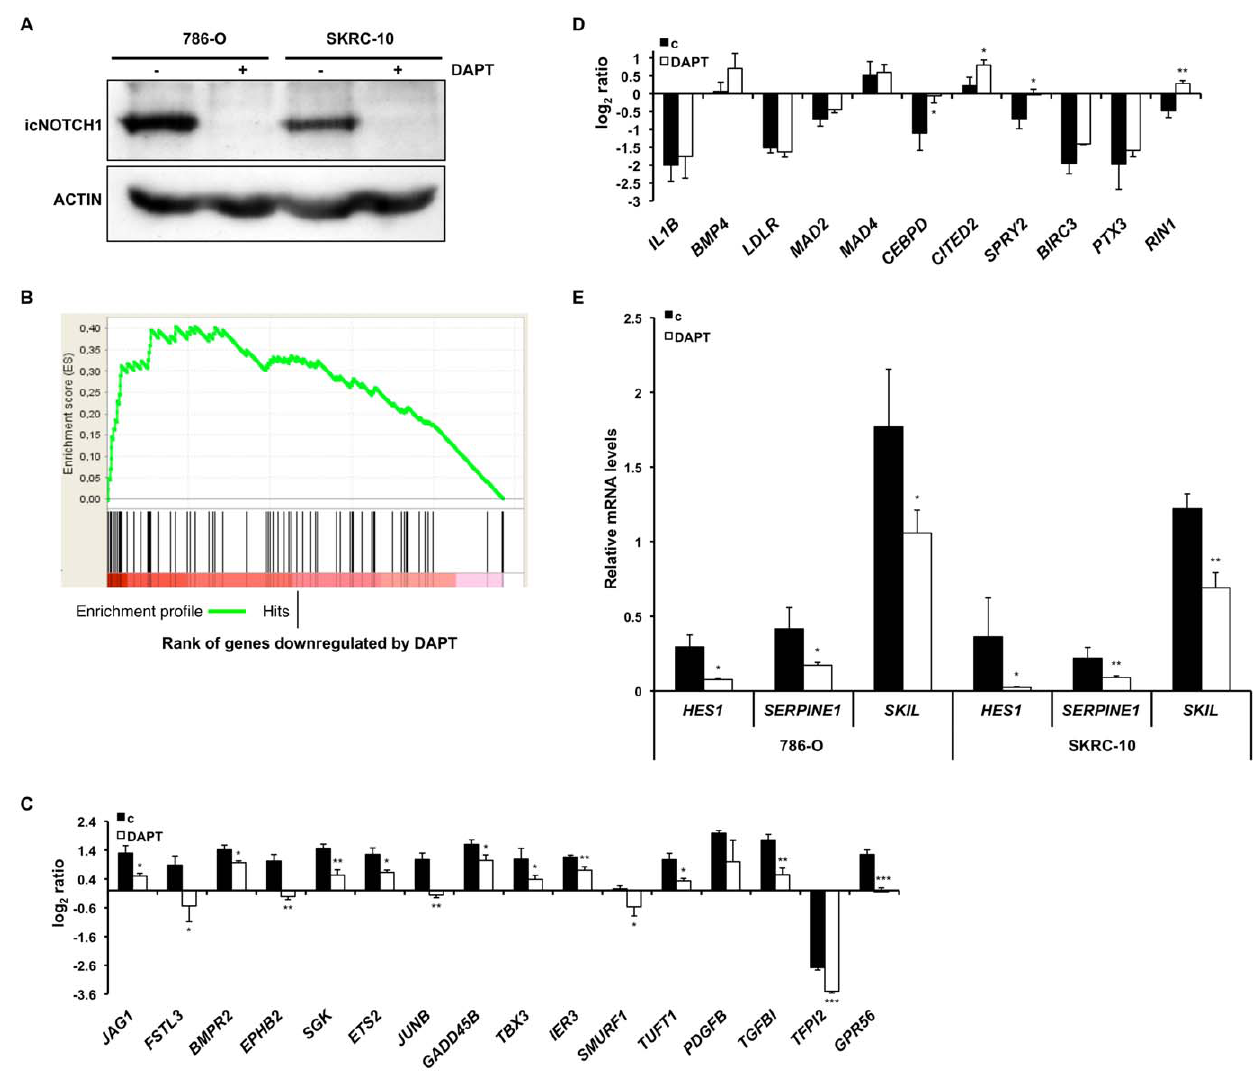
Figure 1. Notch inhibition in CCRCC cells attenuates TGF- b signaling. ( A ) Western blot analysis of icNotch1 in 786-O and SKRC-10 cells treated for 24 h with DAPT ( + ) or vehicle control ( 2 ). Cell extracts were separated by SDS-PAGE and after transfer the membrane was probed with an anti-cleaved Notch1 antibody. The blot was reprobed with an anti-ACTIN antibody to ensure equal loading. ( B ) GSEA of a TGF- b upregulated gene set classified as upregulated by TGF- b 1 treatment of skin fibroblasts at 1–4 h in the SKRC-10 microarray data. Isolated and purified RNA from SKRC-10 cells, treated with DAPT or vehicle control in 1% FCS supplemented media for 24 h, was used in oligomer microarray experiments. Genes in the SKRC- 10 data list were ranked for downregulation upon DAPT treatment by measure of rank product analysis FDR. Gene sets with a q-value below 0.25 were considered significantly enriched. Genes upregulated by TGF- b 1 from the gene set were significantly enriched in the list ranked by downregulated by DAPT (NES=1.75, q=0.09). ( C ) Gene expression analysis of indicated genes reported to be activated in response to TGF- b in DAPT or vehicle control (c) treated SKRC-10 cells. Cells were treated as indicated in ( B ). Data represents mean log 2 ratios + 95% confidence intervals of three separate experiments. ( D ) Gene expression analysis of indicated genes reported to be repressed in response to TGF- b in DAPT or vehicle control (c) treated SKRC-10 cells. Cells were treated as indicated in ( B ). Data represents mean log 2 ratios + 95% confidence intervals of three separate experiments. ( E ) Notch inhibition in CCRCC cells decreases the mRNA expression of the Notch primary target HES1 and the TGF- b target genes SERPINE1 and SKIL . Q-PCR analyses of HES1 , SKIL and SERPINE1 mRNA levels in 786-O or SKRC-10 cells treated for 24 h with DAPT or vehicle control (c). mRNA levels were normalized to SDHA , YWHAZ and UBC expression and data represents mean + 95% confidence intervals of three separate experiments. ***, ** and * indicates statistical significant changes (two-sided Student’s t-test, p , 0.001, p , 0.01 and p , 0.05 respectively).